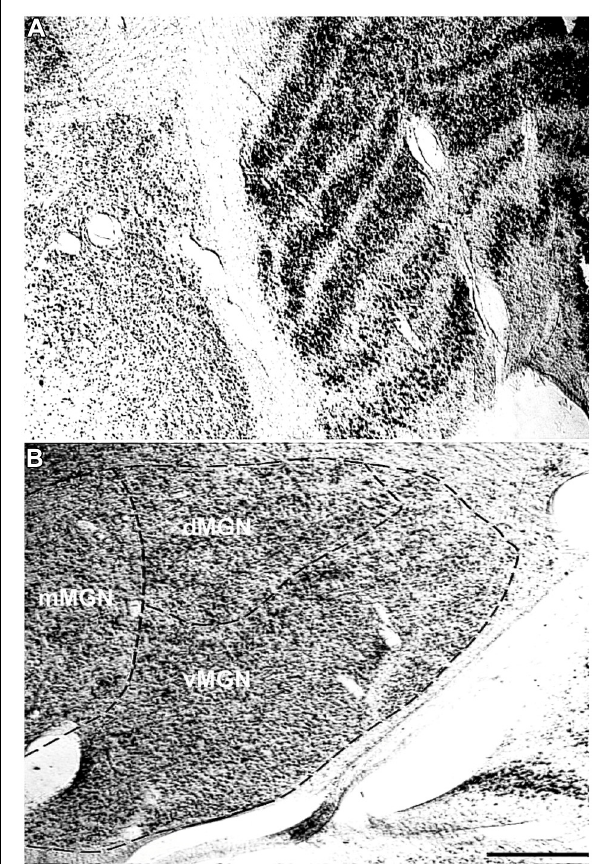
FIGURE 1 | Representative Nissl stains of the sensory thalamus. (A) Transverse Nissl stained section showing the anatomical proximity of the medial and lateral geniculate nuclei. (B) The three subdivisions of the MGN, the ventral (vMGN), dorsal (dMGN), and magnocellular (mMGN) MGN, defined according to previous conventions (Jones, 2003). All MGN sections were partitioned in this manner for stereological quantifications. The left sides of these images correspond to the medial aspect and the top to the dorsal aspect of the sections. Scale bar = 500 μ m.